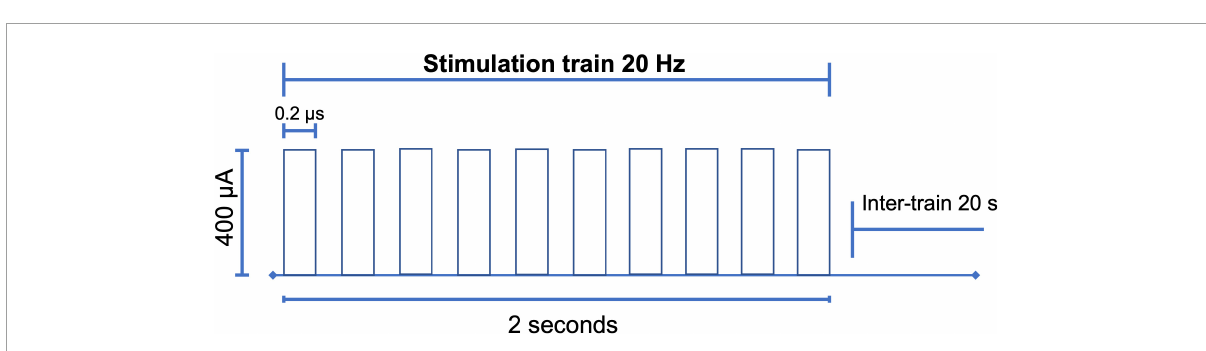
FIGURE3 Timing of electrical stimulation and IA2BC during Time 3. Design of the schedule for repetitive focal electrical stimulation consisting of 10 days with a daily session of 10 min, this period is shown within the blue rectangle between days 120 and 132 of the age of the rat. In total there were 15 sessions where there was a bottle of water and a bottle of alcohol (EtOH-H 2 O) to choose to drink, shown in blue. Between each of these sessions, they were offered two bottles of water (H 2 O-H 2 O).